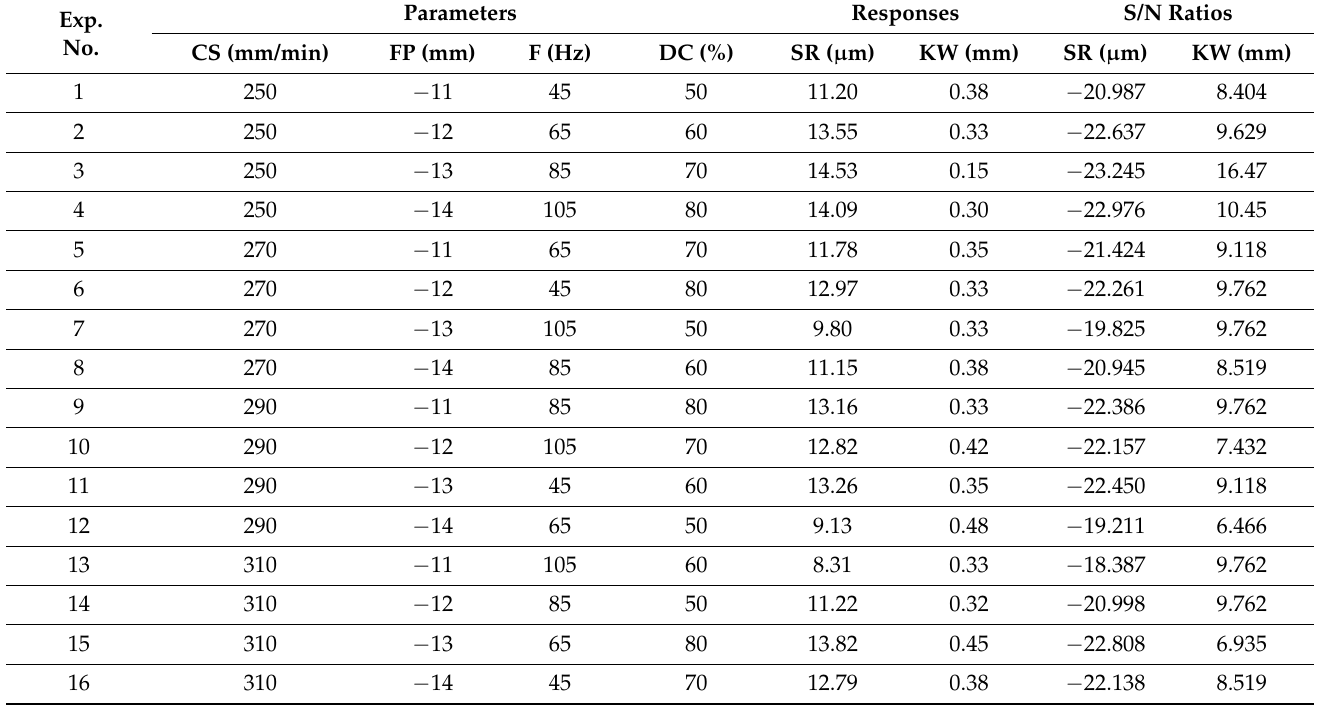
Table 3. Results of Experiment with Design Parameters and Responses and S/N